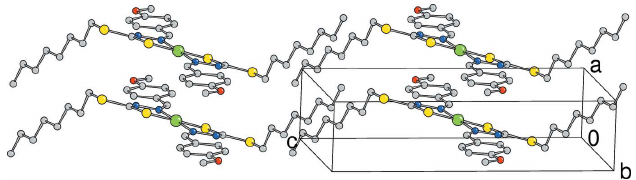
Figure 2 A view approximately along the b axis of the crystal packing of the title